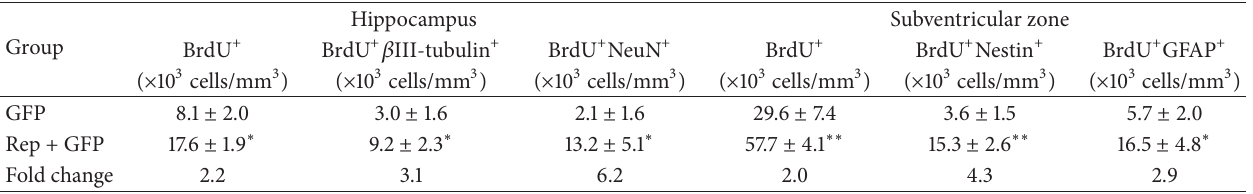
Table 1: Newly generated neurons in the hippocampus and subventricular zone after the in vivo expression of reprogramming factors. To identify newly generated cells, mice were injected daily with BrdU up to 12 days. Eight weeks after the treatment, histological evaluations were